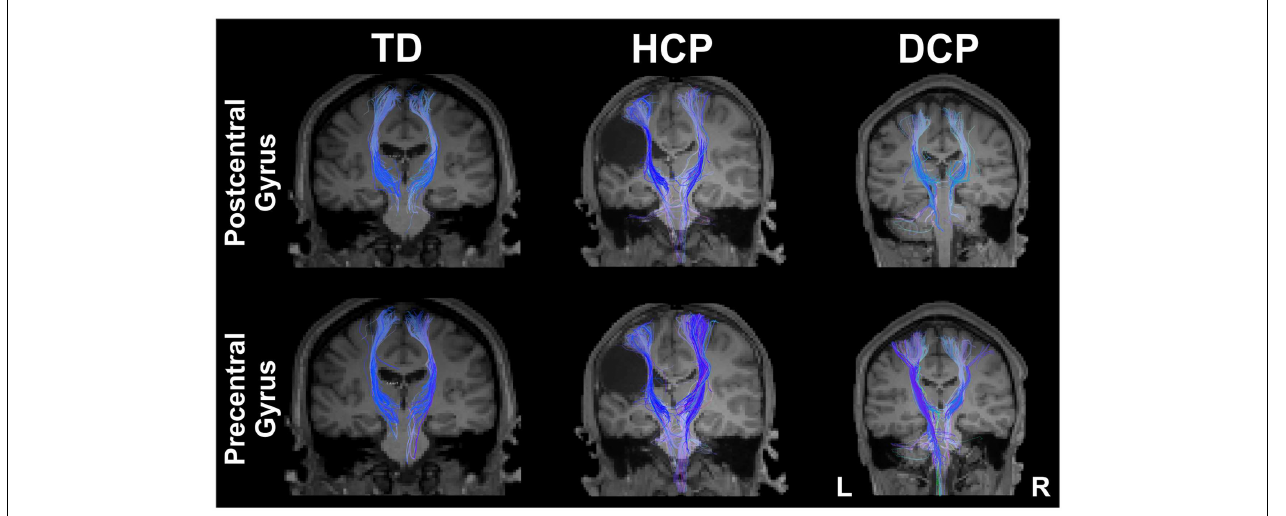
FIGURE 4 |Thalamocortical fibers projecting from thalamus to the post-central gyrus (upper panel) and from thalamus to pre-central gyrus (lower panel) for both sides of the brain for the same participants as in Figure 1 (TD2, HCP1, and DCP3 children)